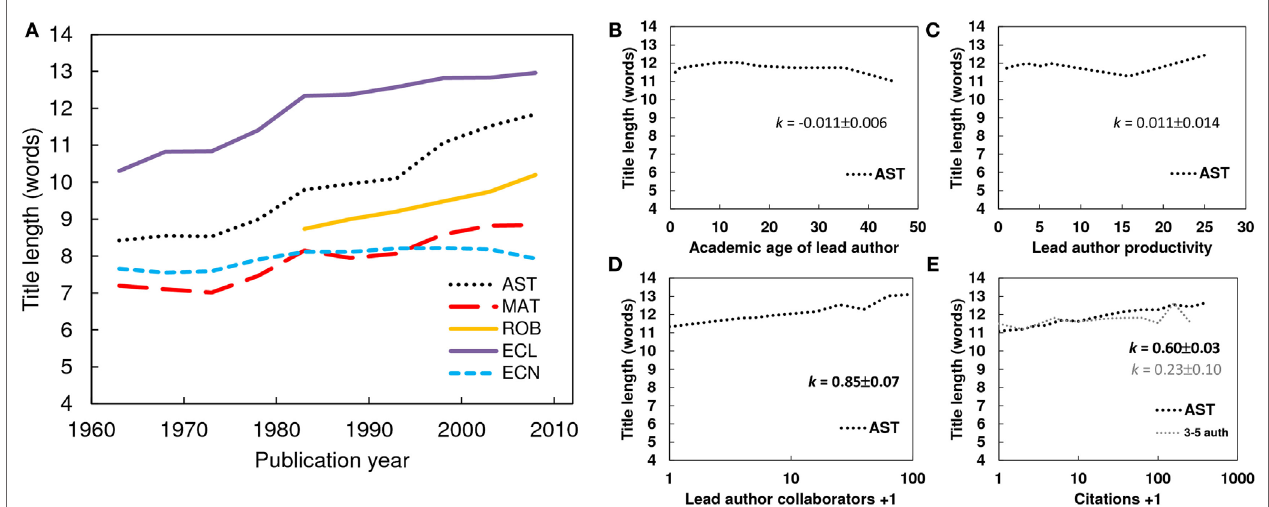
FigUre 1 | Trends involving title length (measured in words) . (a) Average title length for five disciplines [astronomy (AST), mathematics (MAT), robotics (ROB), ecology (ECL), and economics (ECN)] from 1961 to 2010. Data for ROB start in 1983. Data points are averaged in bins of 5 years. (b) Average title length for authors of different academic age (number of years spent in the field) in AST from 2006 to 2010. Data points are averaged in bins of ranging from 1 to 10 years (bin size increases with age). (c) Average title length for authors of different recent productivity in AST from 2006 to 2010. (D) Average title length for authors of different recent collaboration level in AST from 2006 to 2010. (e) Average title length for papers of different impact, measured by citations received through the end of 2013. For panels (c–e) , data are binned in logarithmic intervals of 0.2 decades. Slopes of linear fits and their errors are given for trends in panels (b–e) . Significant trends are emphasized by bold